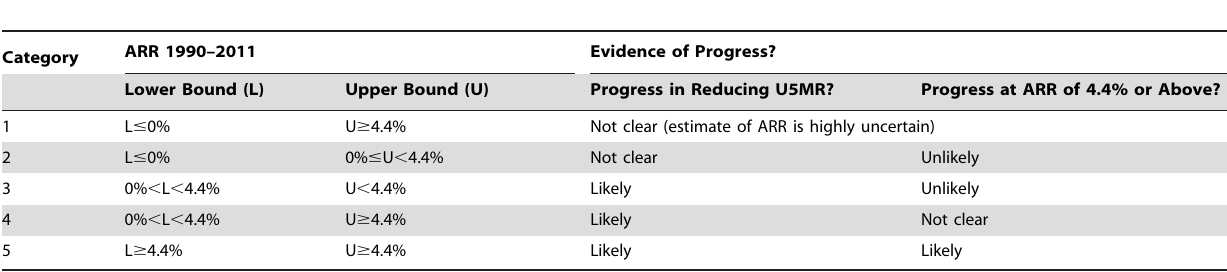
Table 2. Categorization of countries based on evidence for progress in reducing U5MR and accomplishing the MDG 4 target of an ARR of 4.4% from 1990 to 2011.